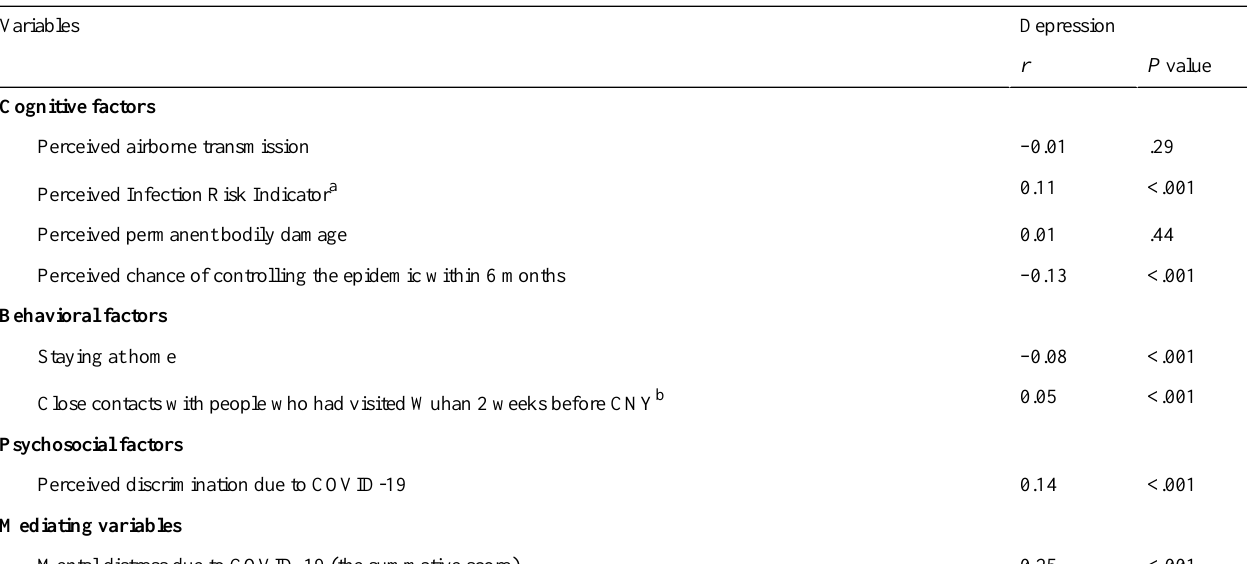
Table 4. Spearman correlations among the independent variables, the mediator, and depression (N=23,863). DepressionVariables